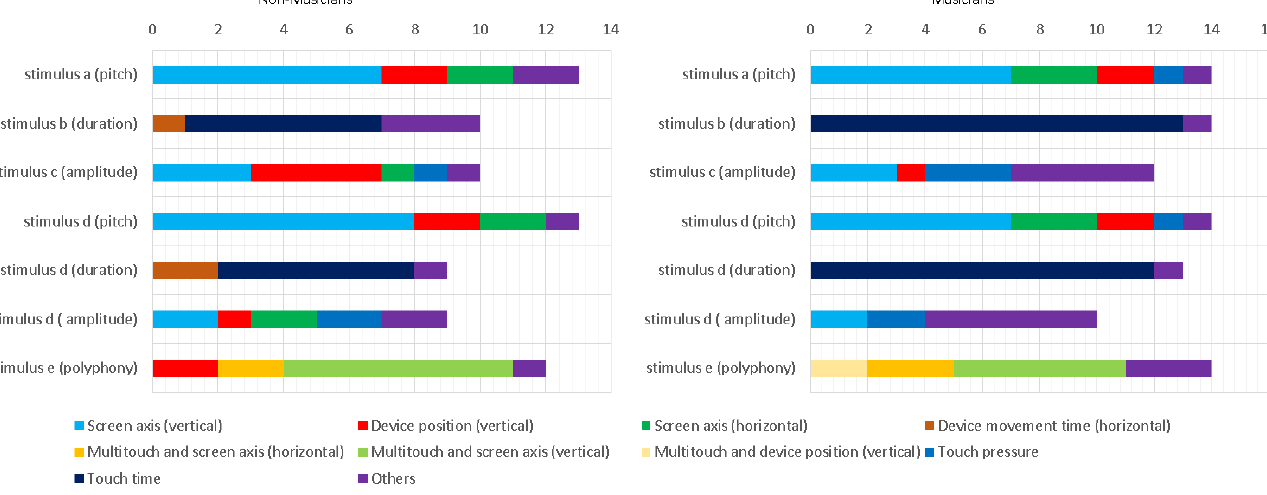
Figure 6. Frequencies of gestures performed by non-musician participants for each stimulus in phase 2. Left : Non-musician participant frequencies; Right : Musician participant frequencies; Full results reference: Tables